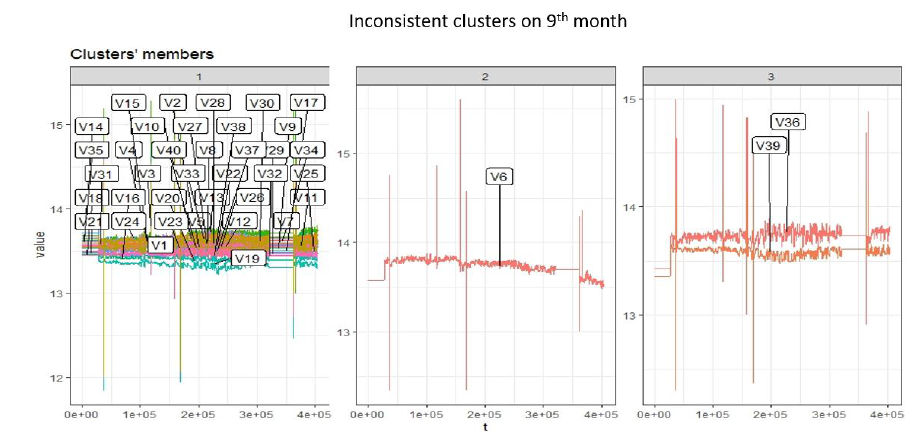
Figure 7. Cluster inconsistency encounter after nine